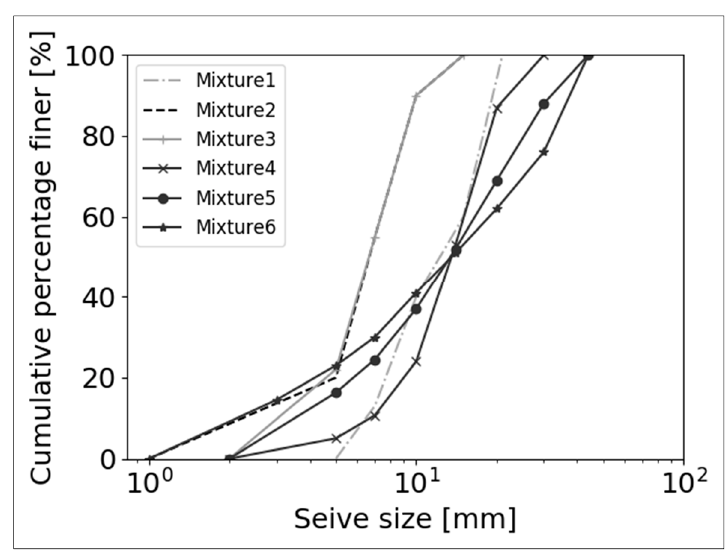
Figure 11. Percentage finer against the sieve size for the 6 tested mixtures.